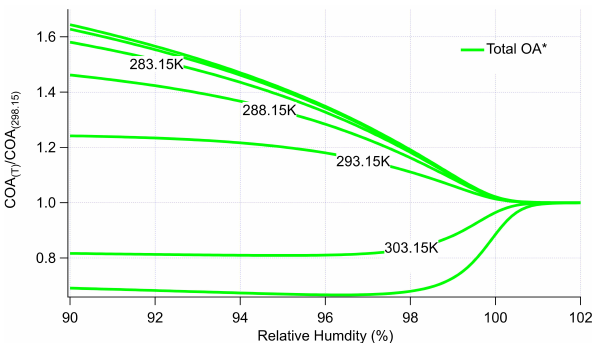
Fig. A1. Ratio of predicted condensed organic material at given temperature COA T /COA 298 . 15 (annotated on each line) to that at 298.15K as a function of RH. The “Total OA” semi volatile distri- bution described in the main body of text is used as an